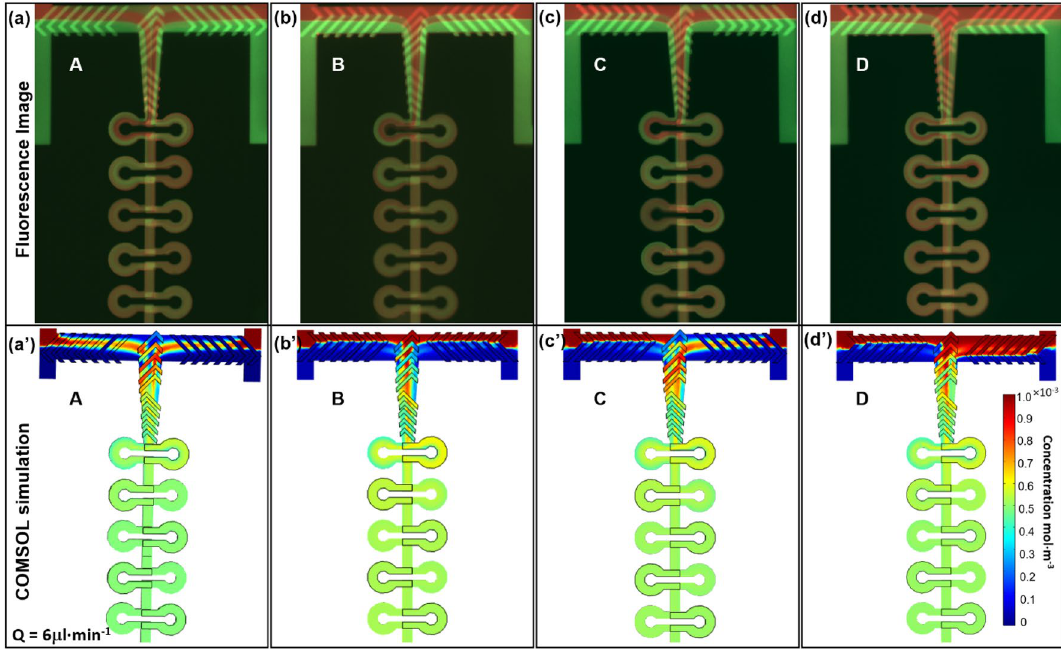
Figure 4. Fluorescence microscopy images (top: a–d ) of the mixing zones in devices with 4 selected SHB designs A, B, C and D, with their corresponding simulation results (bottom: a’–d’ ). Rhodamine B conjugate 70 kDa dextran (red) and Fluorescein (green) are used for fluorescence visualization, with flow rates Q for each inlet of 6 µL·min −1 and Re ca. 20 in the repeated ring-shaped